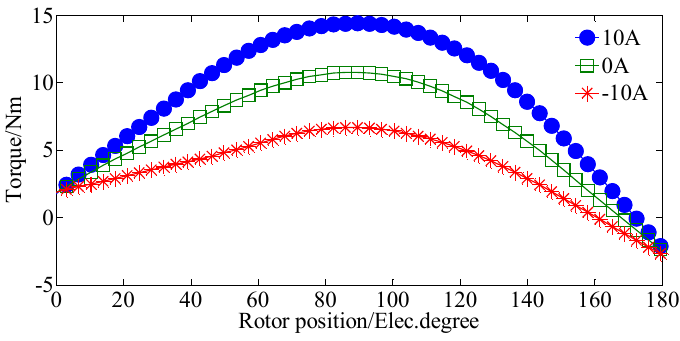
Figure 10. Stationary torque waveforms.